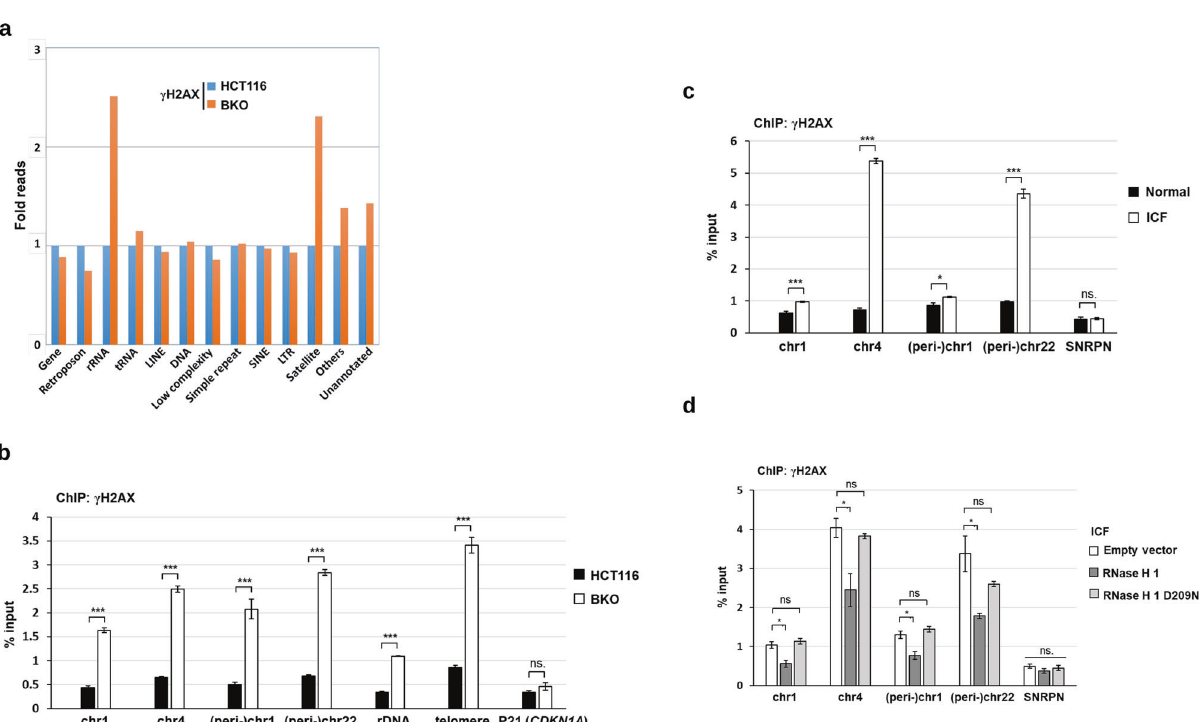
Fig. 3 R-loops-dependent DNA damages at repetitive sequences. a Genome-wide sequencing of DNA damage sites in HCT116 and BKO cells. ChIP by γ H2AX antibody was used for sequencing analysis. The plot shows the relative ChIP-seq reads of γ H2AX at indicated genomic regions in BKO versus control HCT116 cells. Data were from one experiment. b HCT116 and BKO cells were used for γ H2AX-ChIP-qPCR analysis. Data are shown as the percentage of input DNA in γ H2AX antibody at the sequences of (peri-)centromere, rDNA, telomere, and control p21 ( CDKN1A ) regions (mean ± SEM, n = 3, *** P < 0.001, ns: no signi fi cant by two-tailed unpaired Student ’ s t -test). c γ H2AX-ChIP-qPCR in wild-type and ICF LCL cells. γ H2AX-ChIP-qPCR was analyzed at the sequences of (peri-)centromere of chromosome and intergenic region downstream of SNRPN . Data are expressed as percentage of input DNA (mean ± SEM, n = 3, *, *** P < 0.05, 0.001, ns: no signi fi cant by two- tailed unpaired Student ’ s t -test). d γ H2AX-ChIP-qPCR analysis in ICF LCLs after infection with retrovirus of empty HA-vector, HA-RNaseH1-WT, or HA-RNaseH1-D209N. Data are expressed as percentage of input DNA (mean ± SEM, n = 3, *, *** P < 0.05, 0.001, ns: no signi fi cant by two- tailed unpaired Student ’ s t